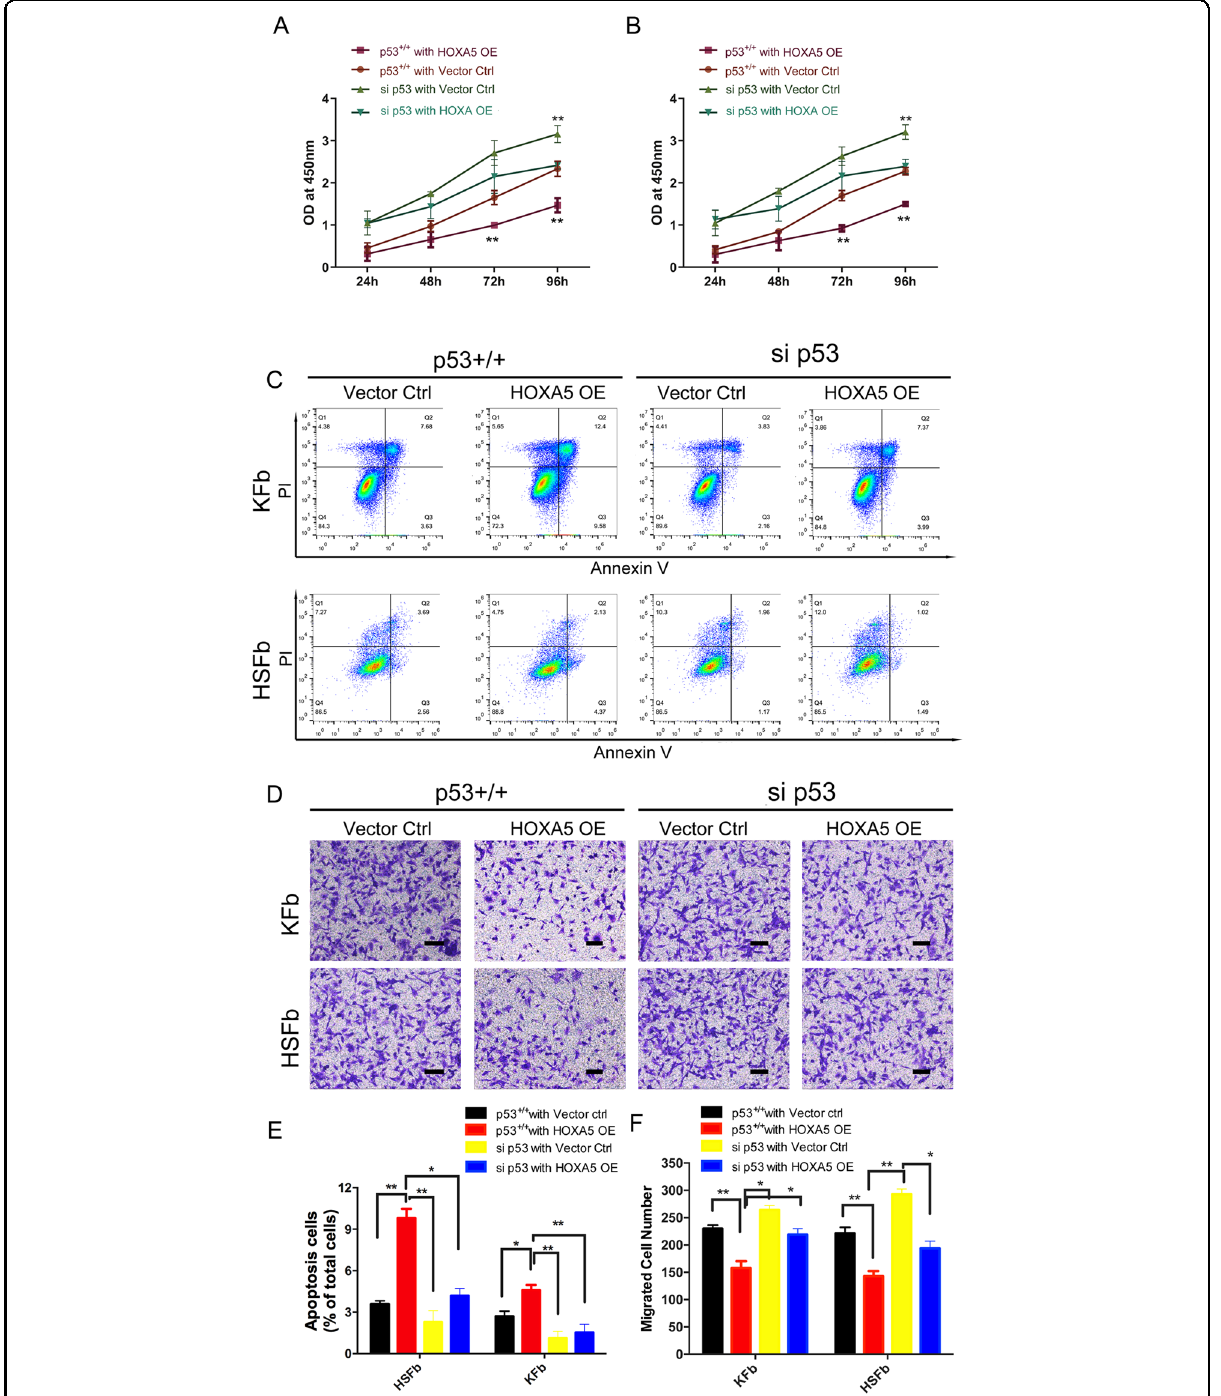
Fig. 5 Knockdown of p53 partially weakens HOXA5-mediated regulation in both HSFb and KFb. A , B Knockdown of p53 partially weakened the HOXA5-mediated regulation of cell proliferation in KFb and HSFb. C , E Knockdown of p53 partially weakened the HOXA5-mediated regulation of cell apoptosis in KFb and HSFb. D , F Knockdown of p53 partially weakened -mediated regulation of cell migration in KFb and HSFb. * p < 0.05, ** p < 0.01. scale bar = 100 μ